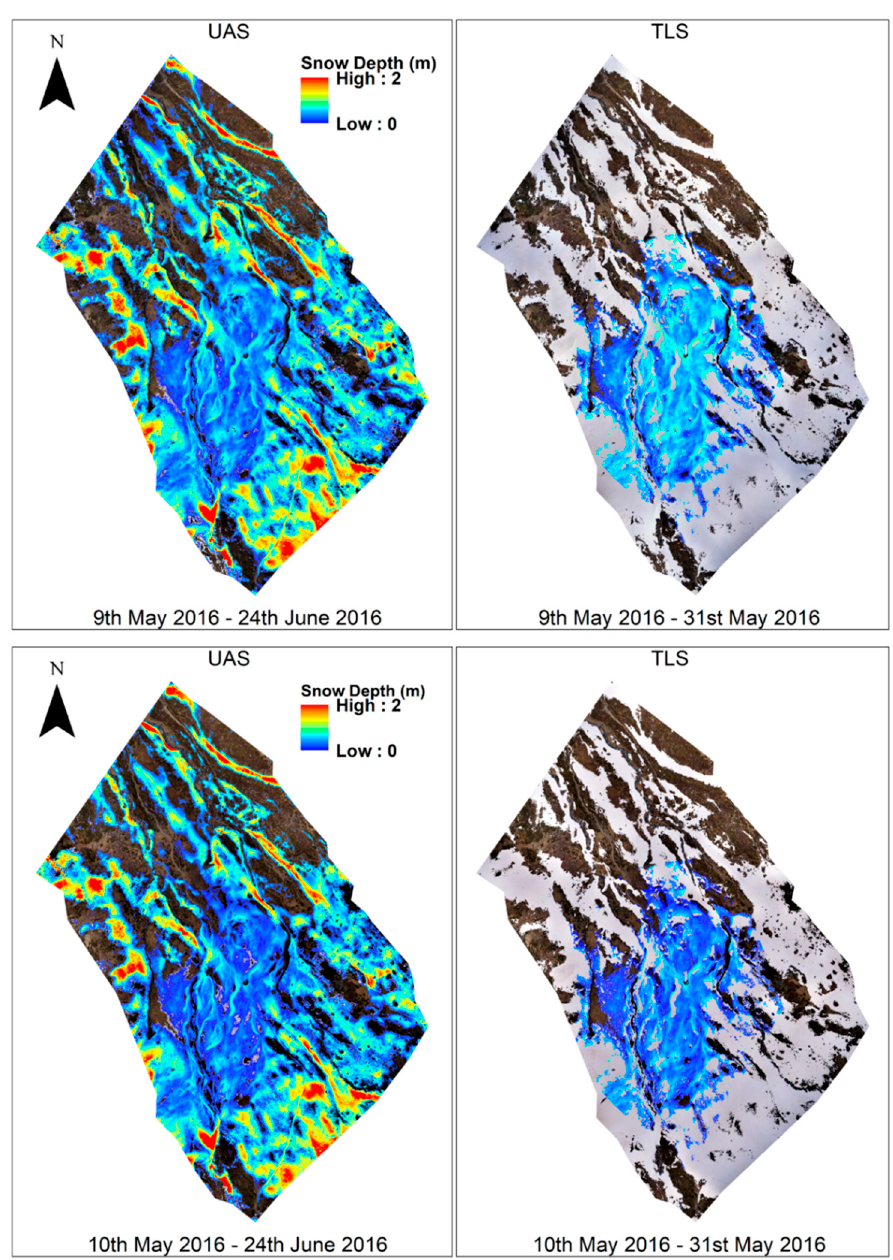
Figure 9. Cont Figure 9. Cont.